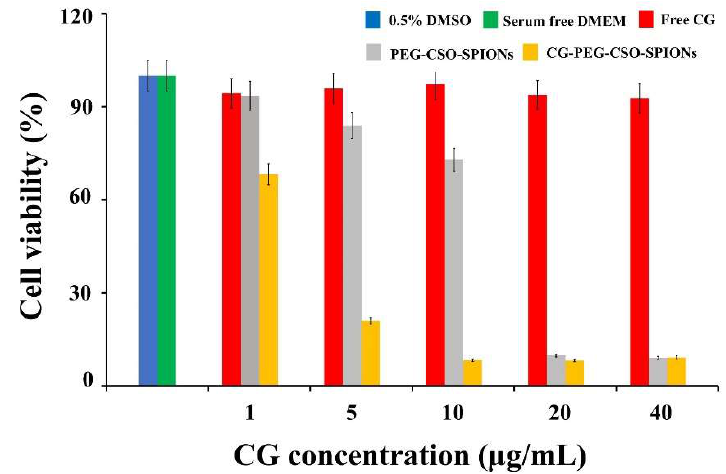
Figure 11. HT-29 cell viability after treatment with control (PEG-CSO-SPIONs), free CG, and CG-PEG-CSO-SPIONs for 24 h. Data are shown as the mean ± SD, derived from four